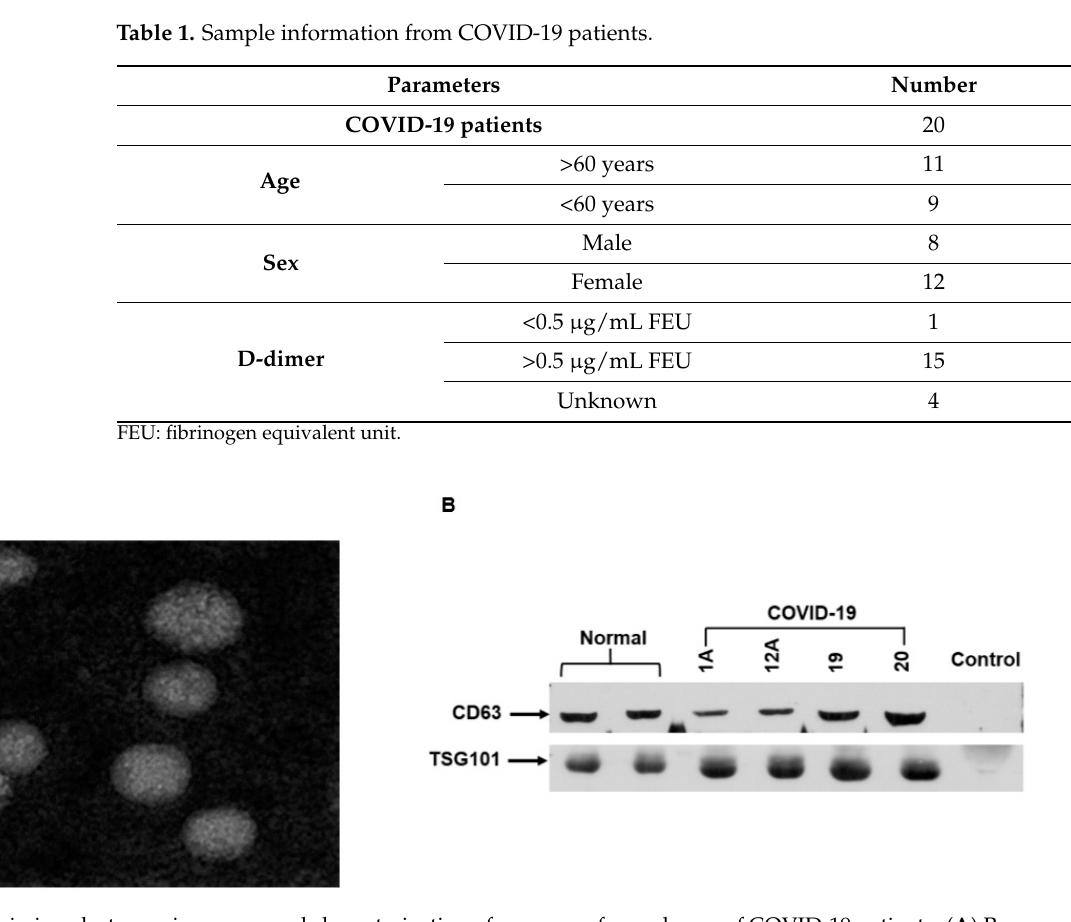
Figure 1. Transmission electron microscopy and characterization of exosomes from plasma of COVID-19 patients. ( A ) Representative transmission electron microscopy (TEM) image of exosomes isolated from COVID-19 patient plasma. The sample grids were screened under a JEOL JEM-1400Plus transmission electron microscope. The exosomes were round in shape with diameters of 30–70 nm. ( B ) Exosome lysates from plasma of normal and COVID-19 patients were subjected to Western blot analysis for detection of CD63 and TSG101 protein using specific antibodies. A representative image shows results from normal and COVID-19 exosomes (1A, 12A, 19, and 20). Exosome depleted serum was used as a negative control.